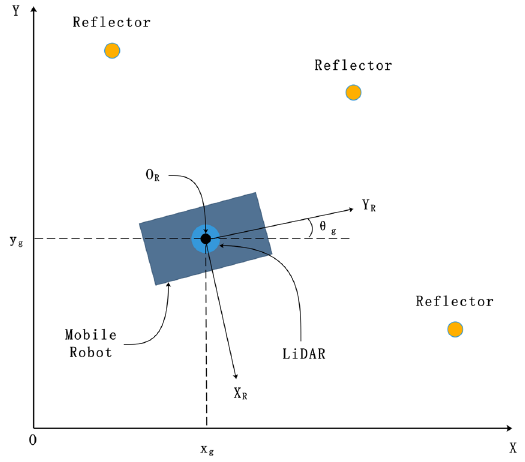
Figure 1. The coordinate system